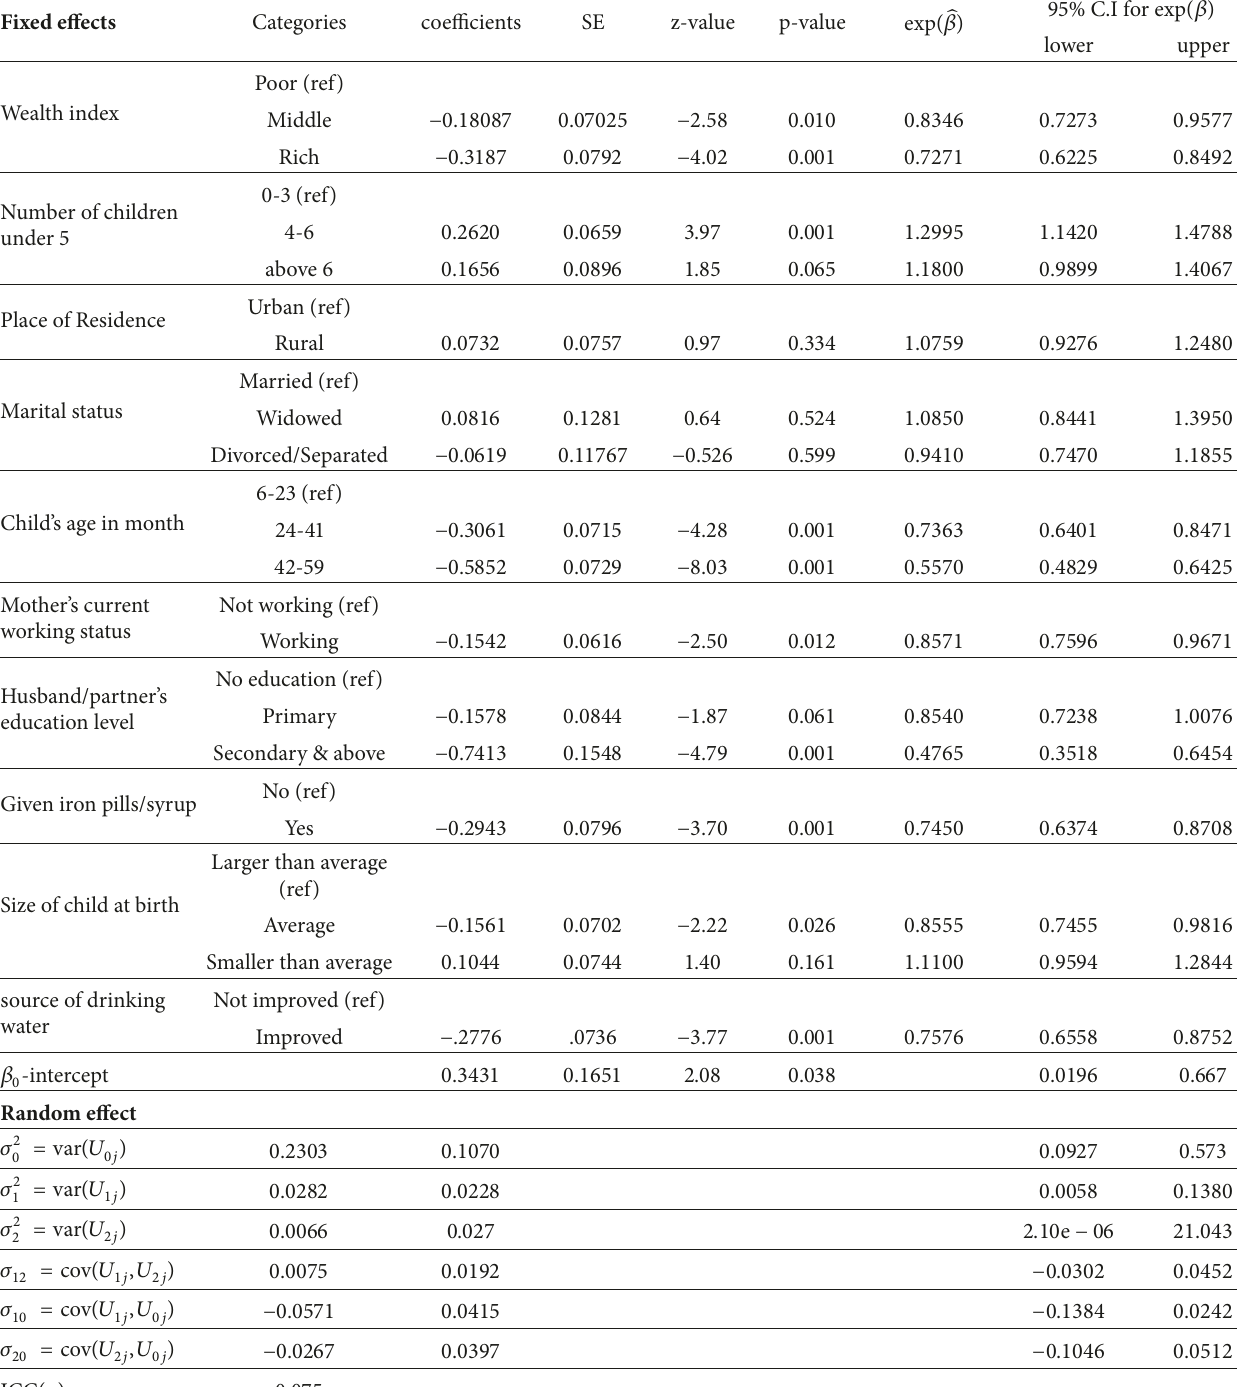
Table 4: Estimates of random coefficients model (EDHS,